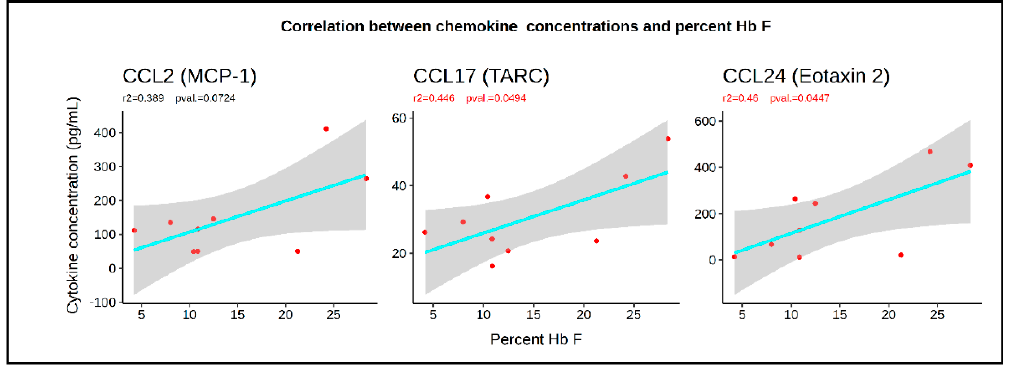
Figure 5. Correlation between HbF levels and the concentration of CCL2, CCL7, and CCL24. Plots illustrating the correlation, r 2 , and F-statistic p -values between HbF and the three chemokines.